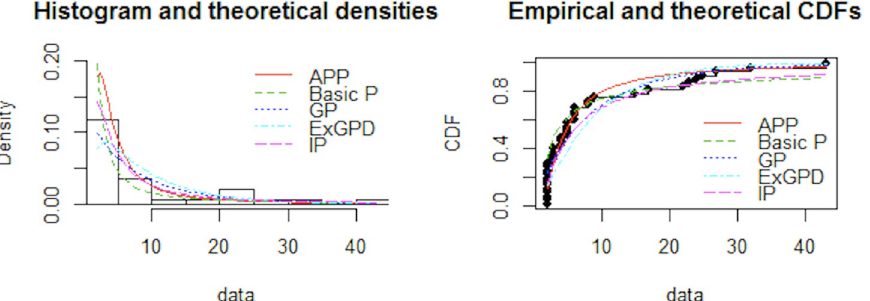
Fig 3. Comparison between fitted distributions for dataset 1.